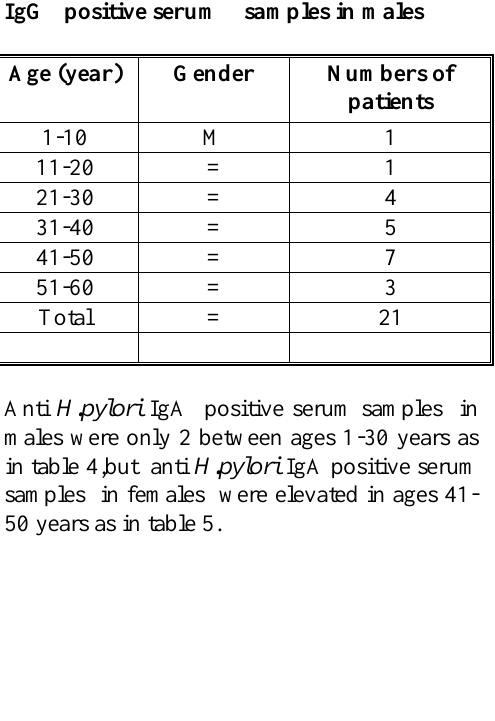
Table (3)Age distribution of anti